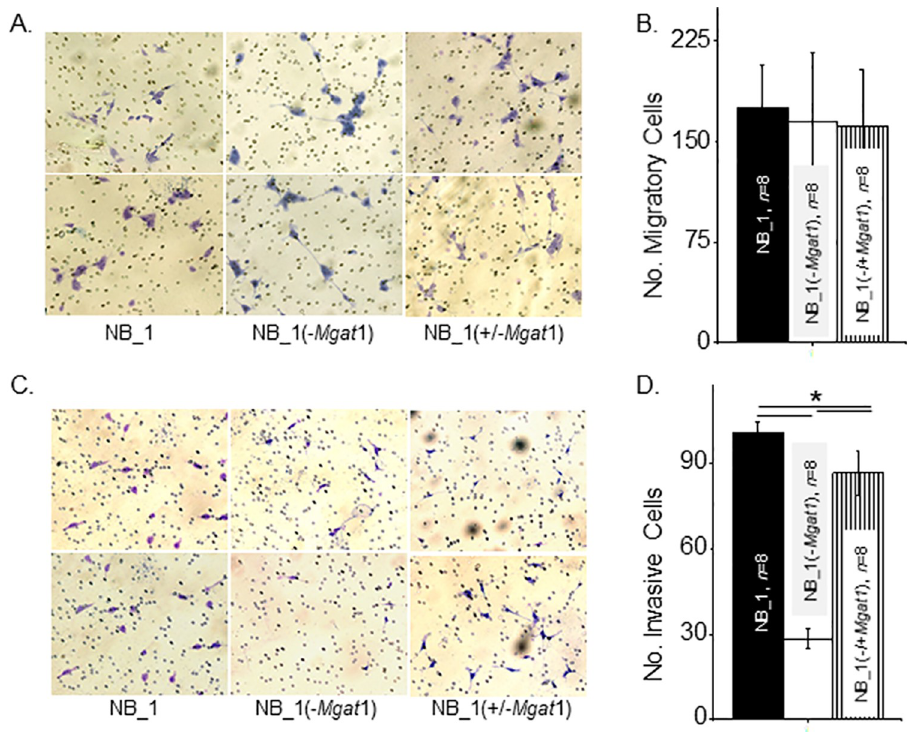
Fig 4. Substitution of complex with oligomannose types of N-glycans on cell migration and invasion of sparse cells. (A) Represented images of migratory parental and glycosylation mutant NB cells from the bottom of the membrane insert contained in transwell chambers after 20 h incubation, as indicated. (B) Quantification of the number of migratory cells that crossed the membrane insert per well. (C) Selected micrographs of invading parental and glycosylation mutant NB cells from Matrigel invasion chambers following a 20 h incubation period. (D) Average number of invasive cells per well. Bright purple migratory and invasive cells and pores in membrane are visible. Data are presented as the mean ± SEM and were compared by one-way ANOVA using Holm-Bonferroni test ( � p < 0.005). n denotes number of wells examined.